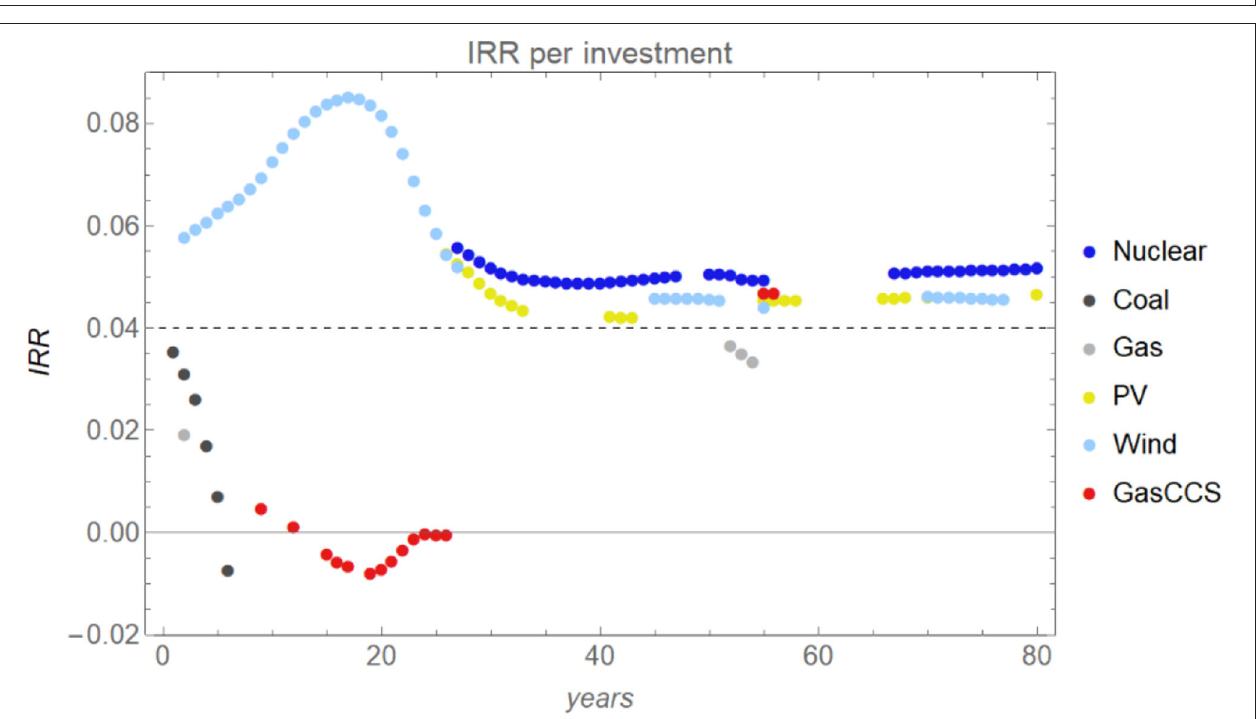
FIGURE 15 | Internal rate of return (IRR) in the fast tax-increase case (increase rate = 4 e per ton CO 2 /year). Each dot indicates the IRR of an investment made in a particular year. The horizontal dash line indicates the 4% bank interest rate.